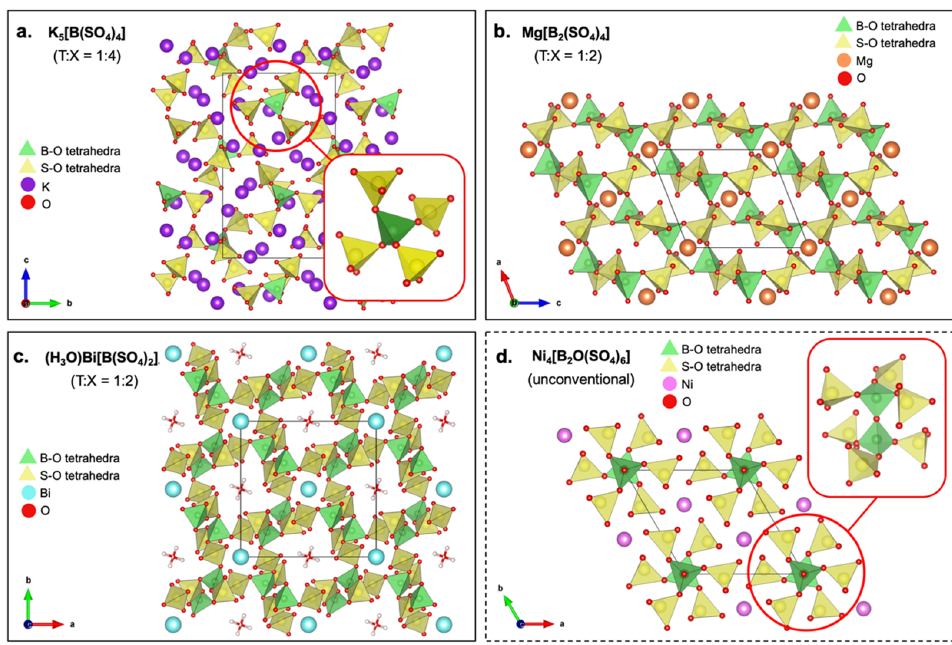
Figure 11. Polyhedral representation of the unit cells of ( a ) K 5 [B(SO 4 ) 4 ] viewed along [100] direction